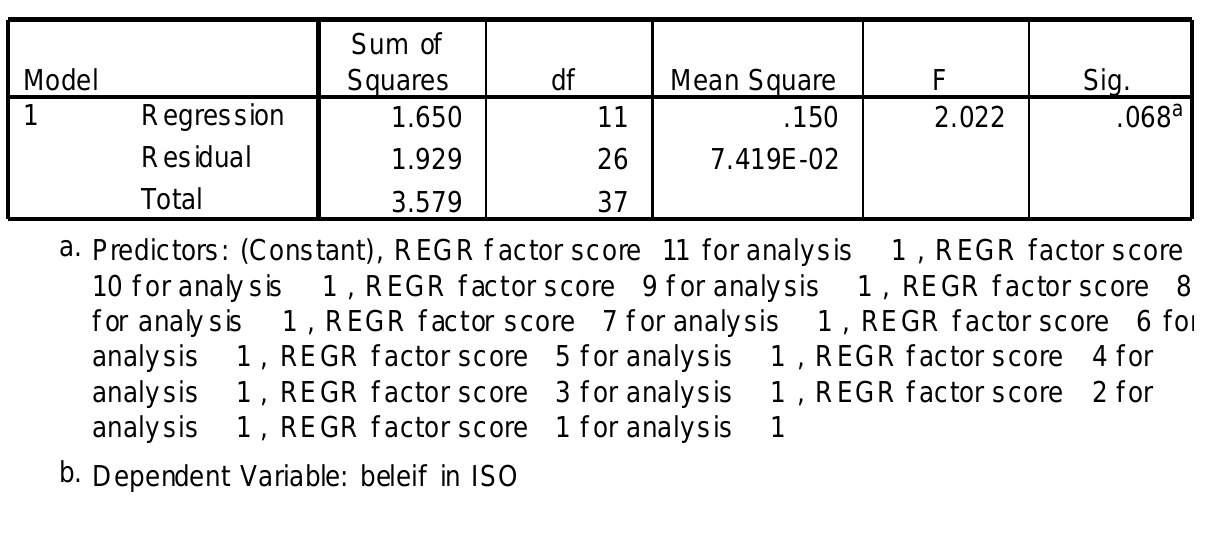
Table III: ANOVA Table for banks’ belief in ISO certificate guaranteeing